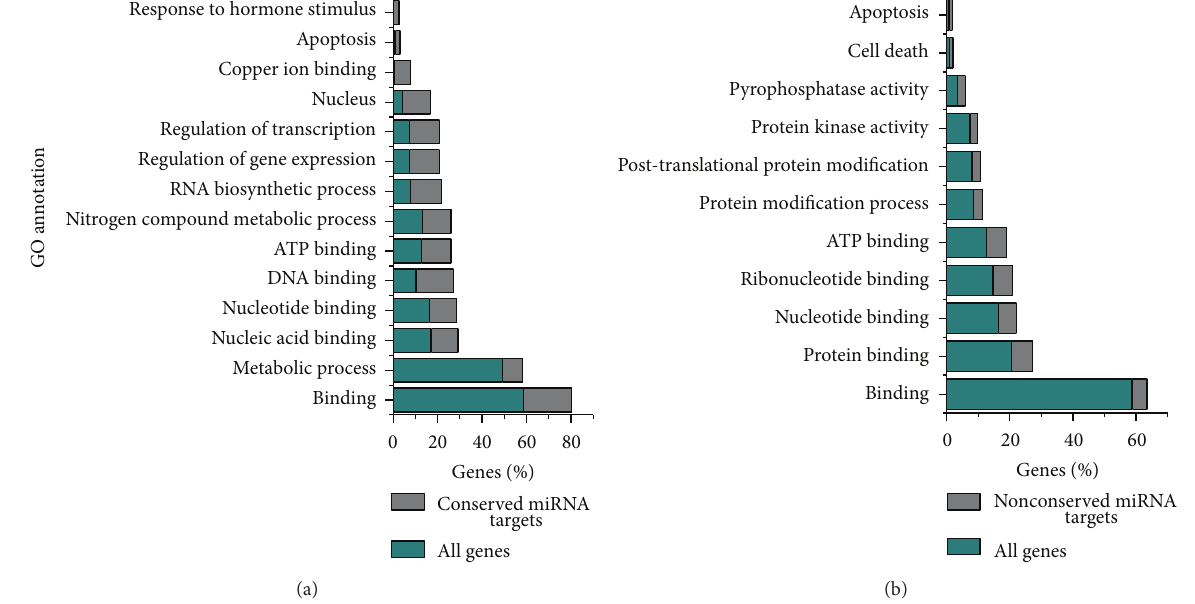
Figure 4: GO enrichment analysis of predicted miRNA targets. (a) Significantly overrepresented GO terms for conserved miRNAs identified in this study. (b) Significantly overrepresented GO terms for possible cassava-specific miRNAs. Cyan and gray bars indicate the fraction of miRNA targets and cassava genes annotated with a corresponding GO term, respectively. See Supplementary Tables 3 and 4 for the full list of significant